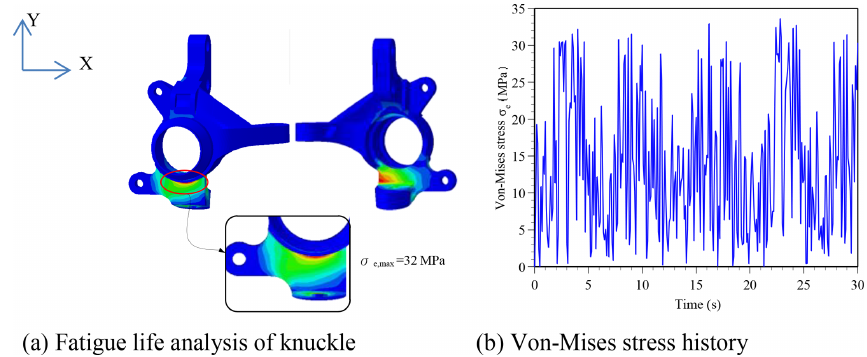
Figure 17. Fatigue life analysis of knuckle for class A road surface.